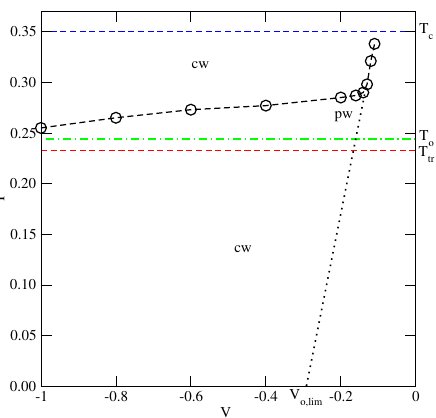
Figure 17. The regions of the complete (cw) and partial (pw) wetting for the systems with u AB = − 0.2. The horizontal dashed lines mark the triple point, the critical point and the order–disorder transition temperatures of the bulk system. The dotted line marks the expected locations of the wetting temperature in isotropic systems with ¯ u = −